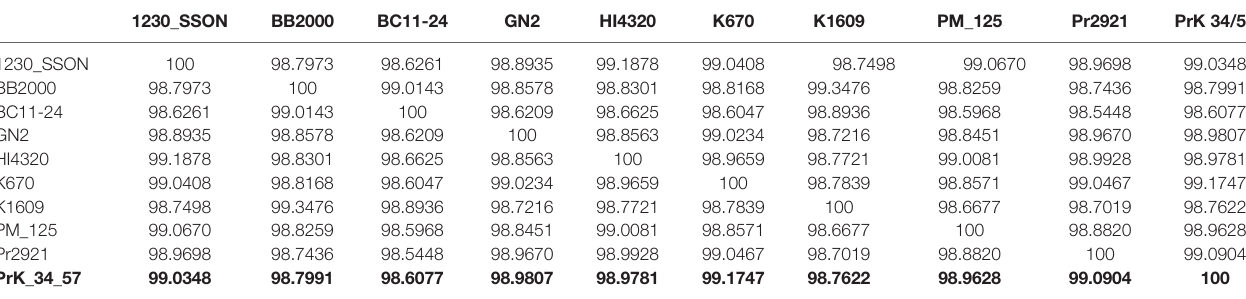
TABLE 5 | ANI similarity matrix between studied Proteus mirabilis genomes.